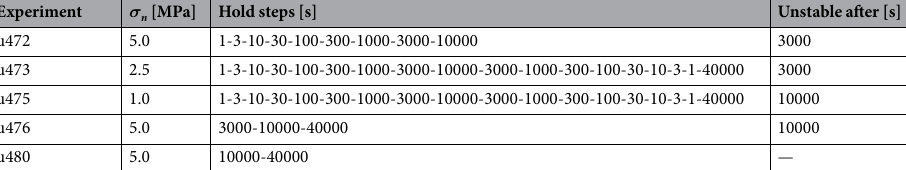
coefficient of friction, and its intercept represents the sample cohesion. Overall, the data at relatively short hold durations ( Δ t < 1000 s) can be captured well with a linear failure envelope (Fig. 3a). For longer hold durations,